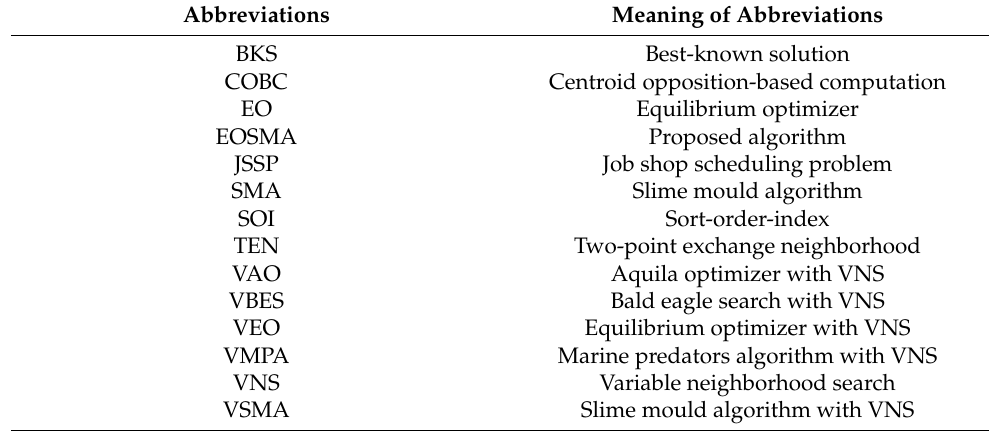
Table 1. List of